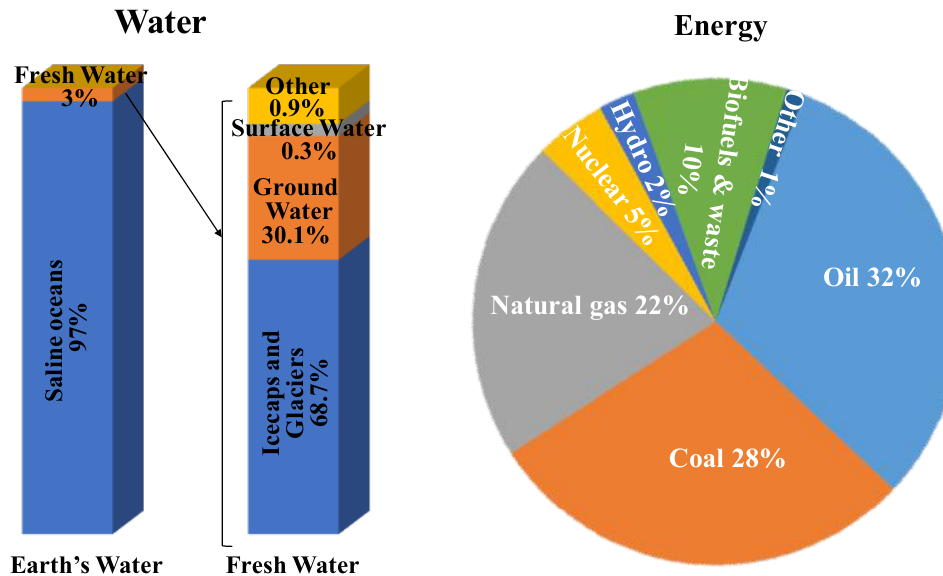
Figure 1. Current availability of water and energy resources [2,4,9].